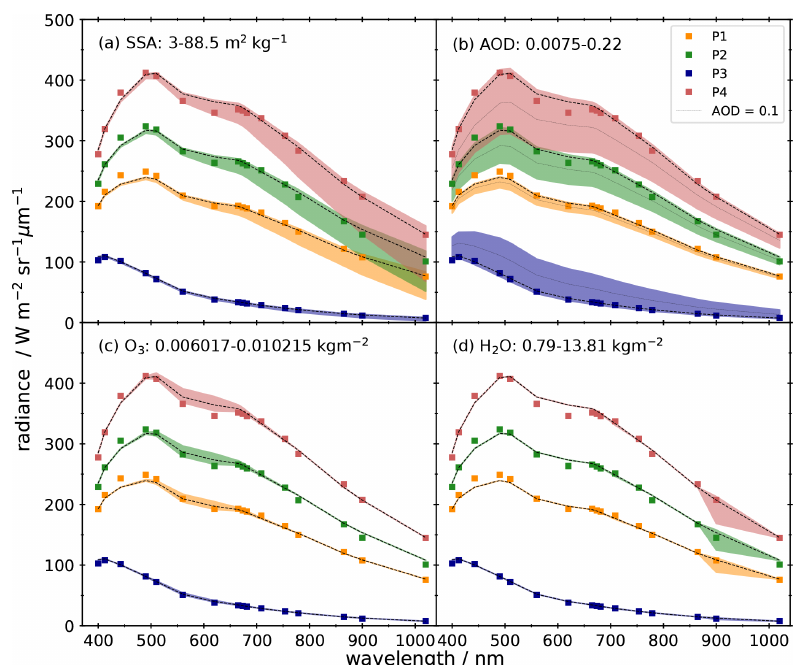
Figure 9. Sensitivity of the rugged-terrain TOA radiance to the model input parameters for 4 pixels on 13 February 2018. Sentinel-3 OLCI L1B observations (coloured squares) are compared to REDRESS simulations using the parameters described in Table 3 (dashed lines) and varying (a) SSA input values, (b) AOD values (for clarity an intermediate value of 0.1 is represented as a dotted black line), (c) atmospheric ozone column values, and (d) atmospheric water vapour values (coloured